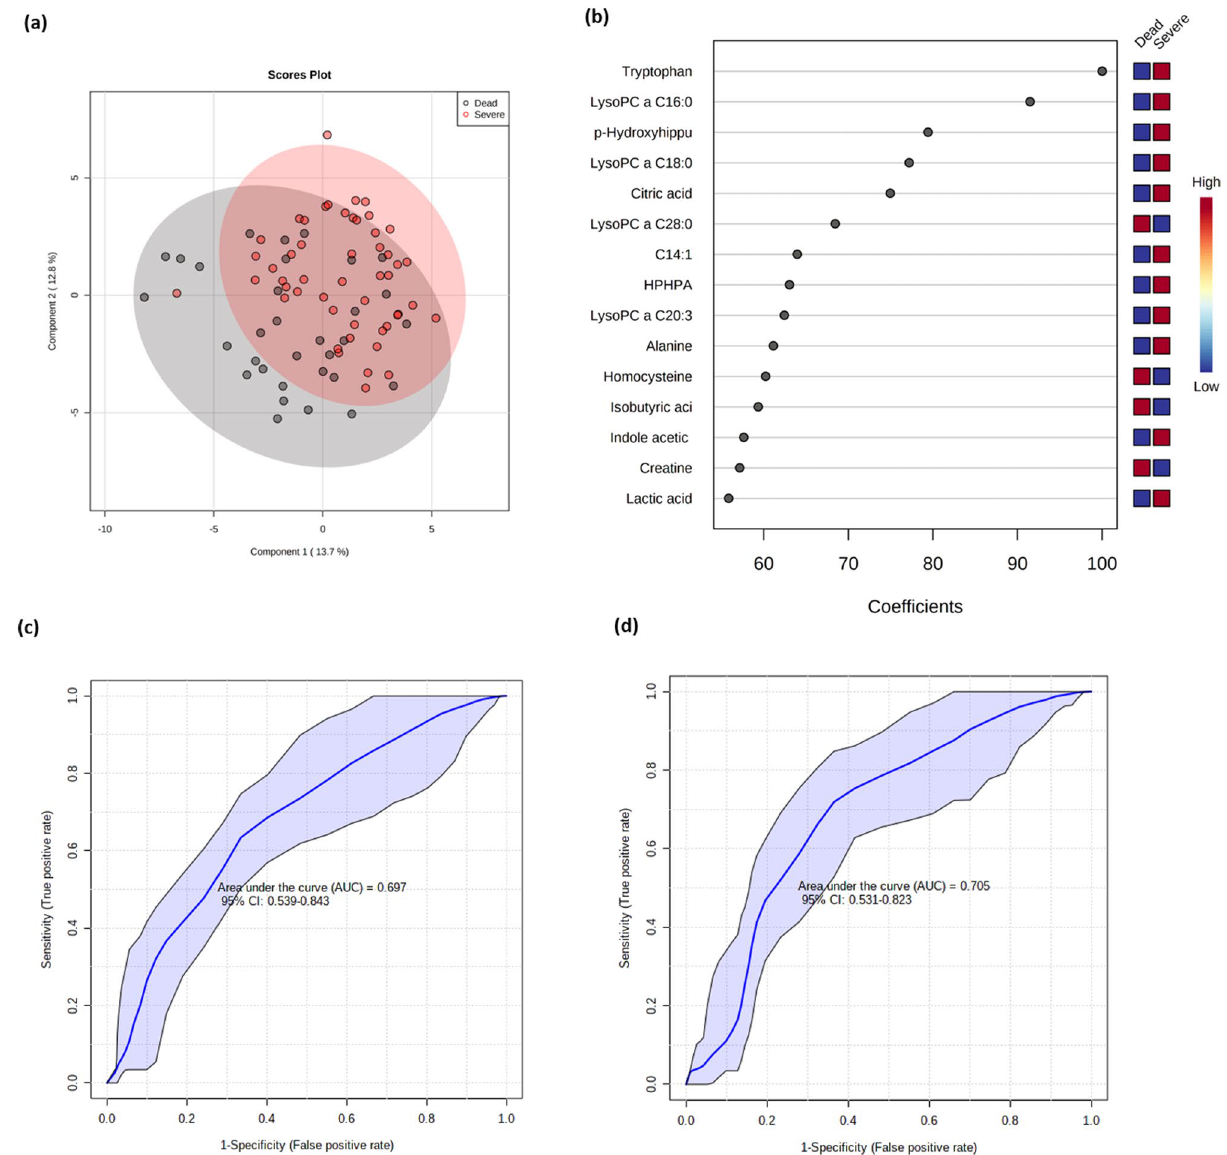
Figure 4. Multivariate analysis from plasma metabolome profile of severe patients versus non-survivors. ( a ) Score scatter plot based on the PLS-DA models to explain the diagnosis (red for severe patients and black for non-survivors, ( b ) rank of the different metabolites (the top 15) identified by the PLS-DA according to the VIP coefficient on the x-axis. The color boxes indicate whether metabolite concentration is increased (red) or decreased (blue) in non-survivors vs severe patients ( c ) ROC curve of the metabolite-only model; ( d ) ROC curve of the metabolite + demographic/clinical data model. The figures were drawn via metaboanalyst software v 4.0 (https:// www. metab oanal yst.